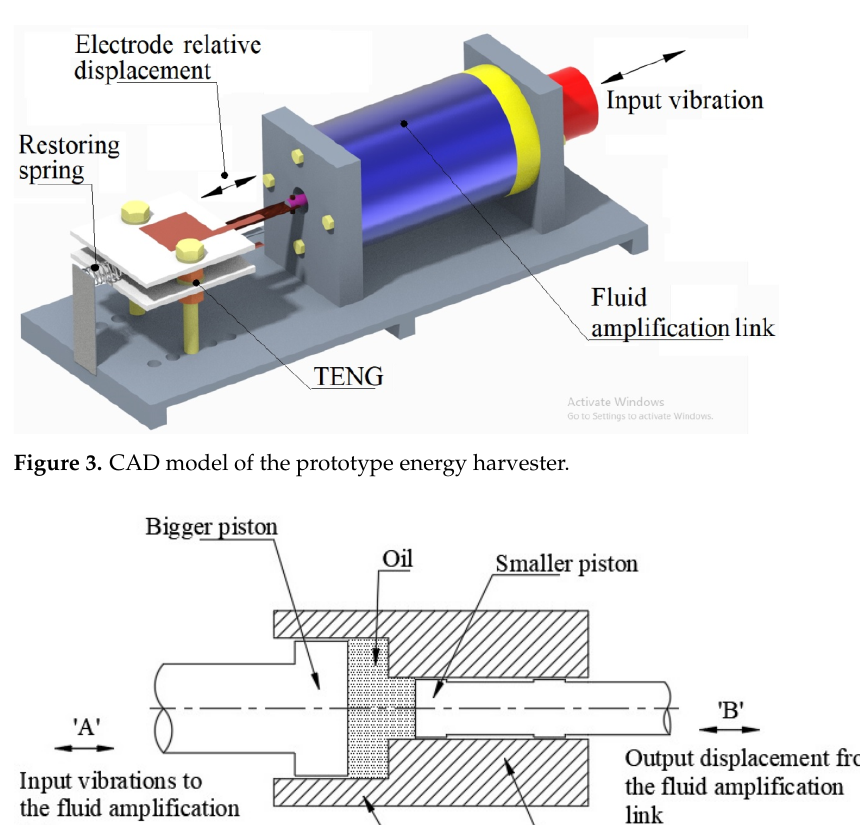
Figure 2. Arrangement in the prototype energy harvester.